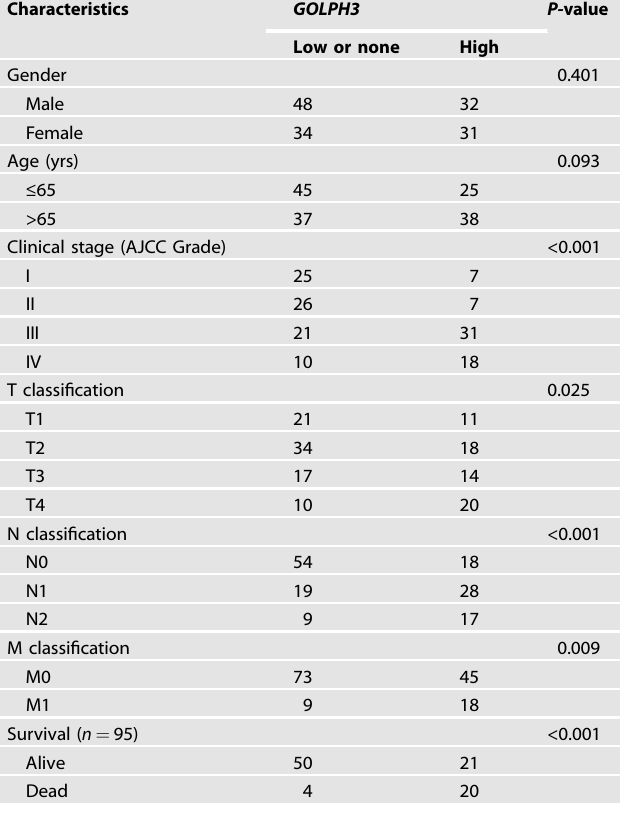
Table 2. Correlation between the clinical pathologic features and expressions of